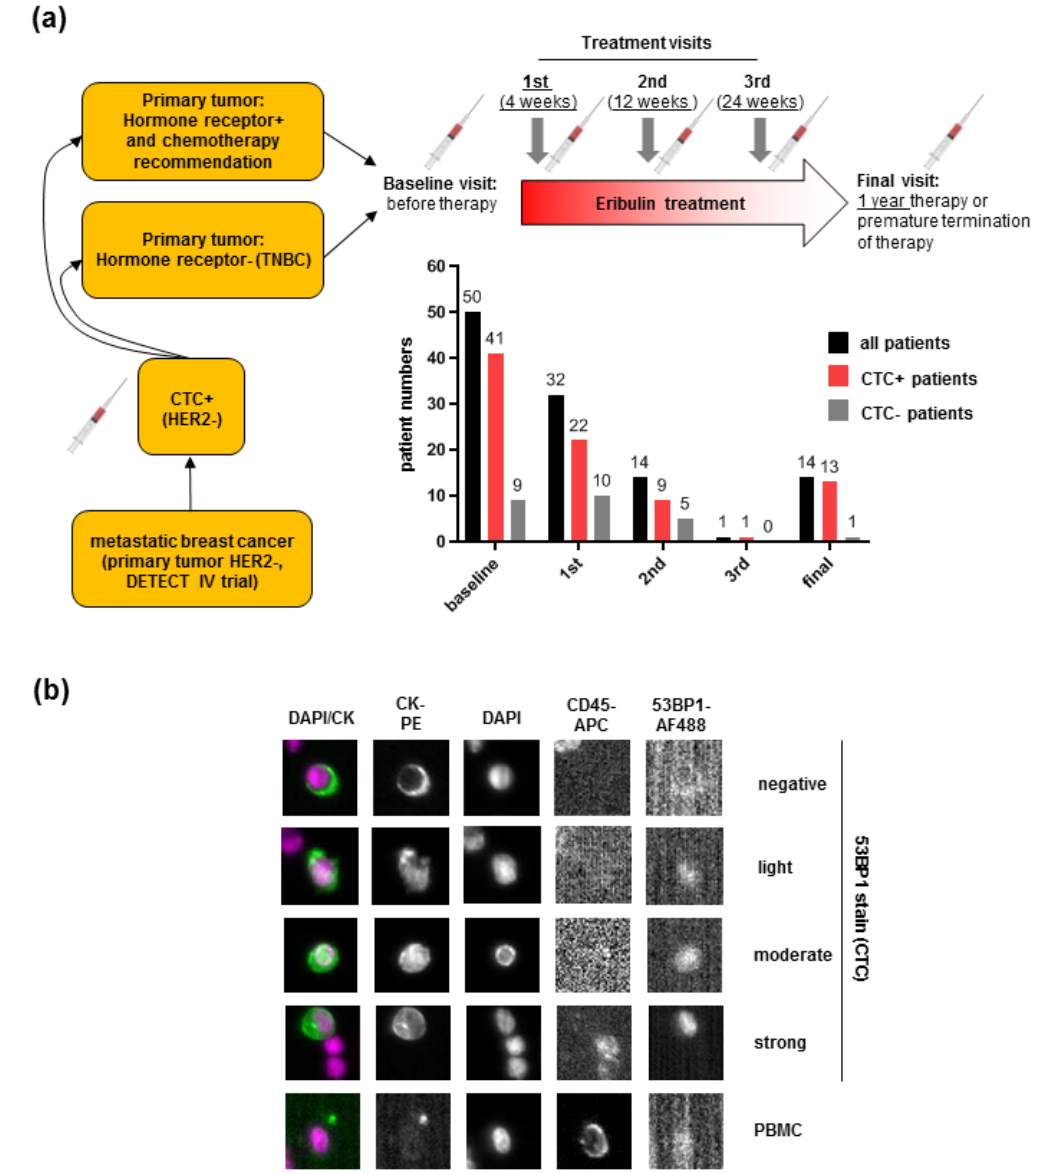
Figure 1. Detection of 53BP1 in CTCs from MBC patients in the DETECT IV trial. ( a ) Selection of MBC patients with CTC-positivity (HER2-) and primary TNBC or primary HER2-, HR + breast cancer for Eribulin monotherapy and blood sample collection. Blood samples were drawn before therapy (baseline visit), four, twelve, and 24 weeks after the start of Eribulin treatment (1st, 2nd, and 3rd treatment visit) as well as one year after treatment initiation or during premature termination due to disease progression (final visit). The numbers of patients recruited at the different visits are indicated by black columns, the numbers of CTC+ and CTC- patients among them by red and grey columns, respectively. Note that not all of the patients described in Table 1 entered the study during the baseline visit but during later visits which explains the differences in patient numbers. ( b ) Evaluation of 53BP1 signals in CTCs. Following EpCAM-based CTC enrichment and immunofluorescence microscopic imaging (Cellsearch ® ), CTCs (CK+, CD45-) were enumerated and 53BP1-staining intensity assessed per individual CTC as indicated by representative examples. A 53BP1 score per patient sample was calculated from the percentage of CTCs without and with light, moderate or strong staining. PBMC, peripheral blood mononuclear cell (CK-, CD45+).